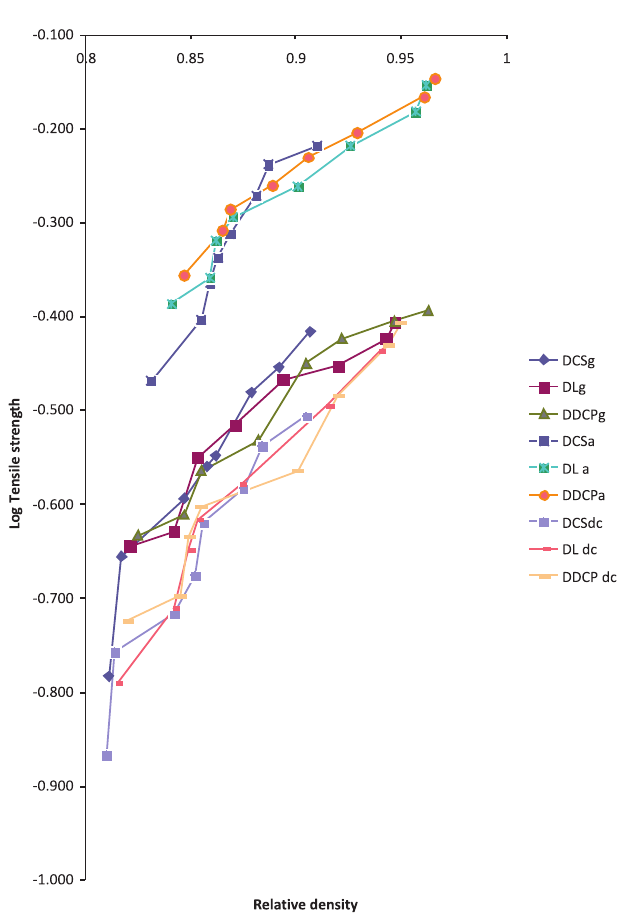
FIGURE 3 - Representative plots of log tensile strength versus relative density for diclofenac TABLE III - Values of Tensile strength (T) of diclofenac tablets at relative density of 0.900 Formulation